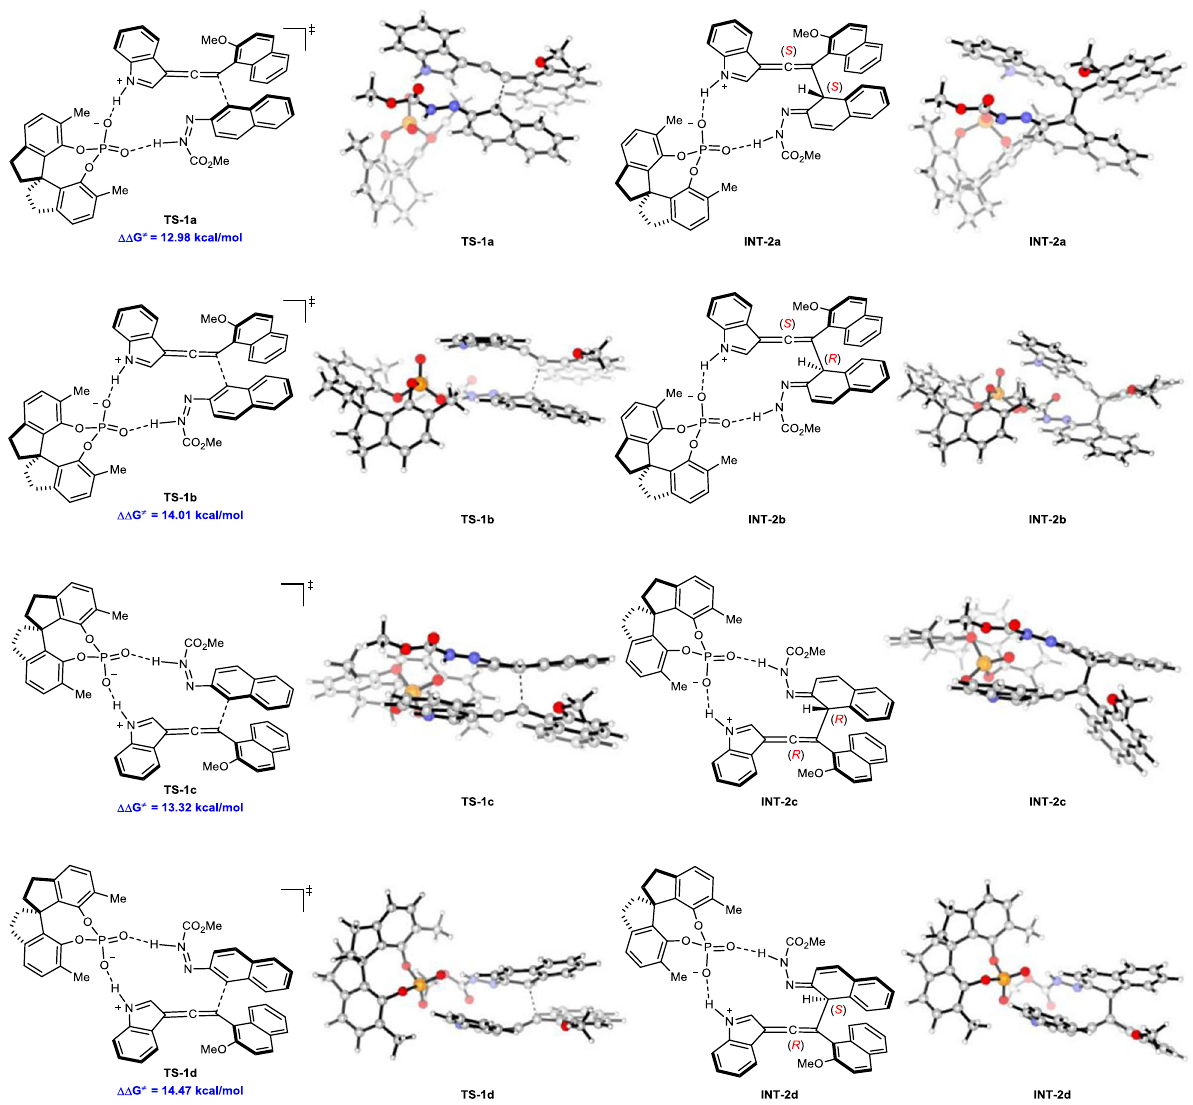
Fig. 6 DFT calculations. DFT-optimized chiral phosphoric acid-catalyzed transition states TS-1a – d , and their corresponding allene – iminium intermediates INT-2a – d